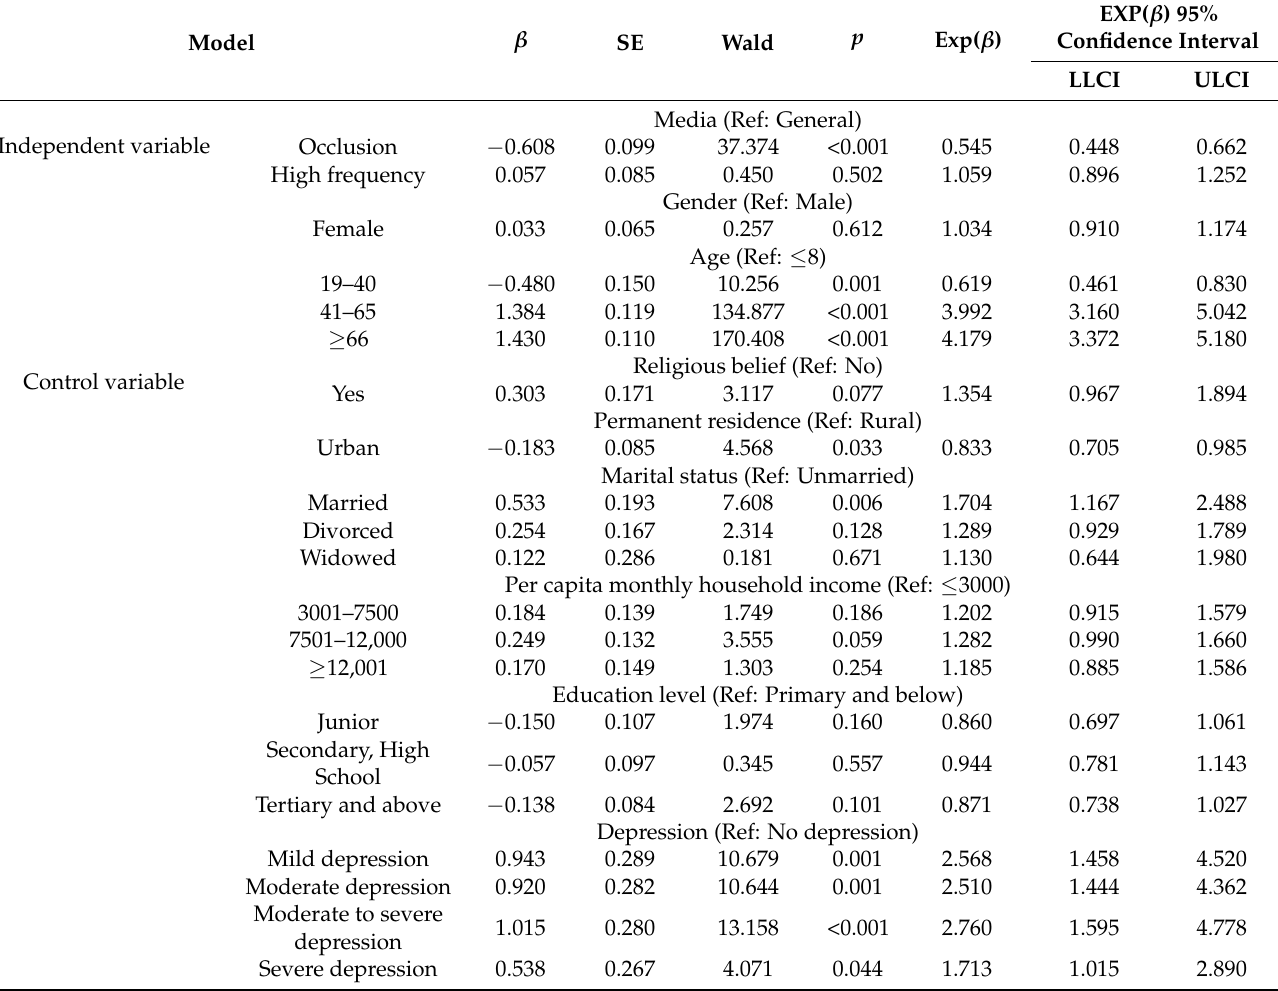
Table 4. Binary logistic regression analysis of factors affecting COVID-19